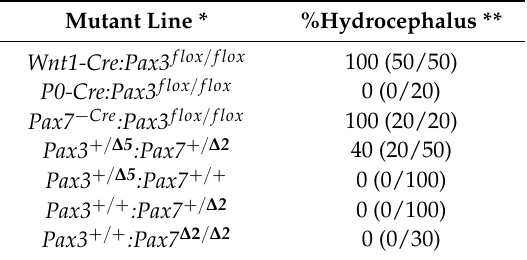
Table 1. Hydrocephalic incidence in mouse lines with conditional, systemic, or haploinsufficient mutations of Pax3 and/or Pax7 . Summary of hydrocephalus in the different mouse lines is indicated (*); the occurrence is sex-independent on mixed genetic background; presence of hydrocephalus (**) was determined by gross and/or anatomical (coronal sectioning) examination of postnatal animals one week old and